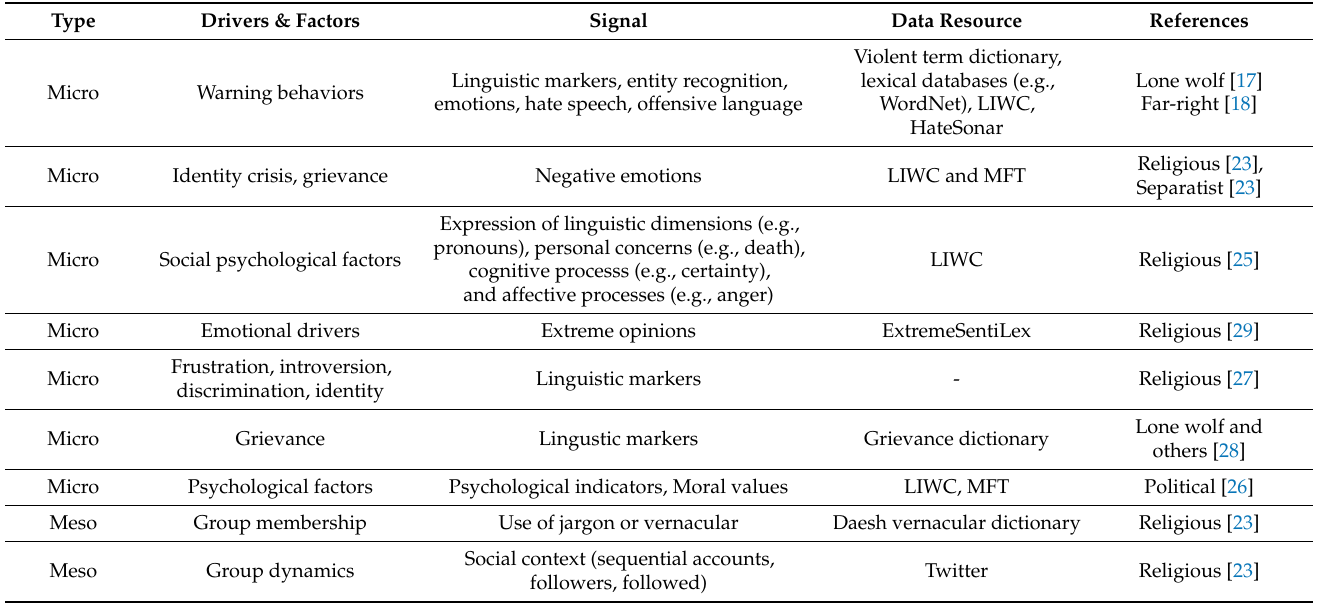
Table 1. Summary of literature survey regarding language signals for monitoring